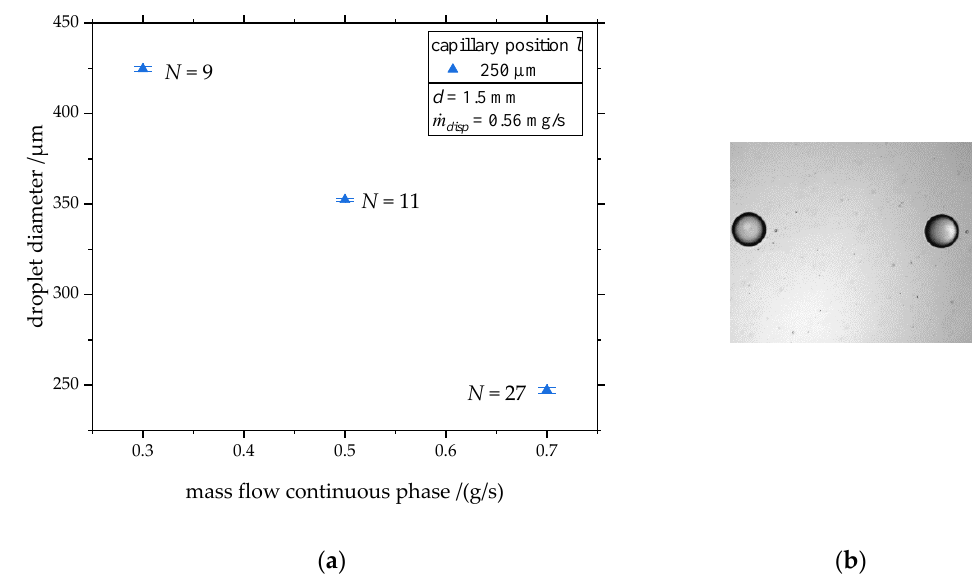
Figure 6. ( a ) Droplet diameter as a function of the mass flow of the continuous phase. The diameter of the orifice was 1.5 mm and the tip of the capillary was positioned in a distance of 250 µm from the orifice exit. The mass flow of the disperse phase was set constant to 𝑚̇ 𝑑𝑖𝑠𝑝 = 0.56 mg/s . N represents the number of droplets that were found in the set of 100 images. ( b ) Exemplary raw image of two droplets with equal diameter.